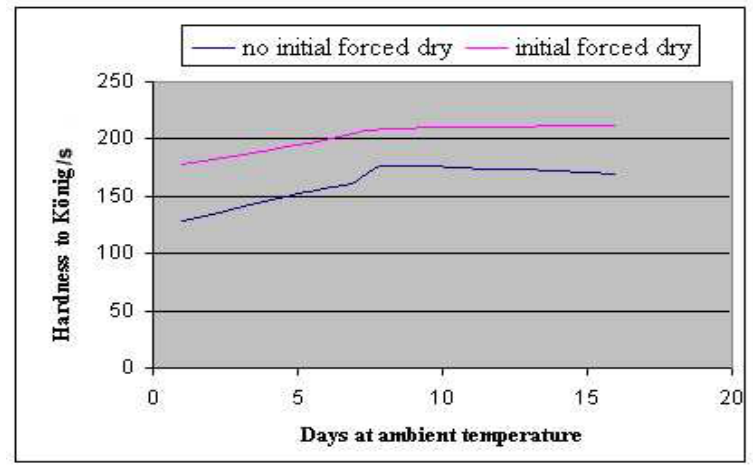
Figure 5 . Hardness development of the Polyol*1 based paint depending on the temperature.